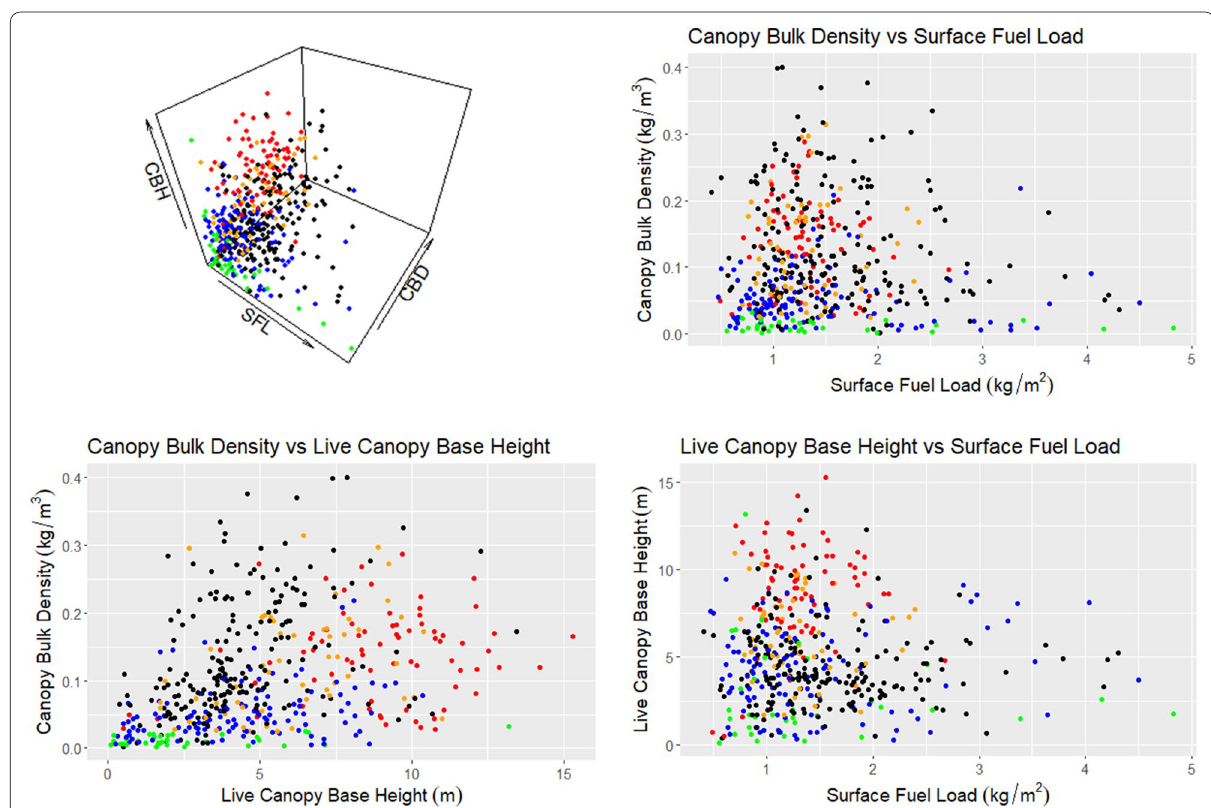
Fig. 4 Scatter plots of observations of surface fuel load (SFL), live canopy base height (CBH), and canopy bulk density (CBD) and corresponding FBP System fuel type denoted by reference colours: C-3 Mature Jack or Lodgepole pine, red; M-1/M-2 Boreal Mixedwood, blue; C-2 Boreal Spruce, black; D-1/D-2 Deciduous, green; and Mixed Conifer, orange